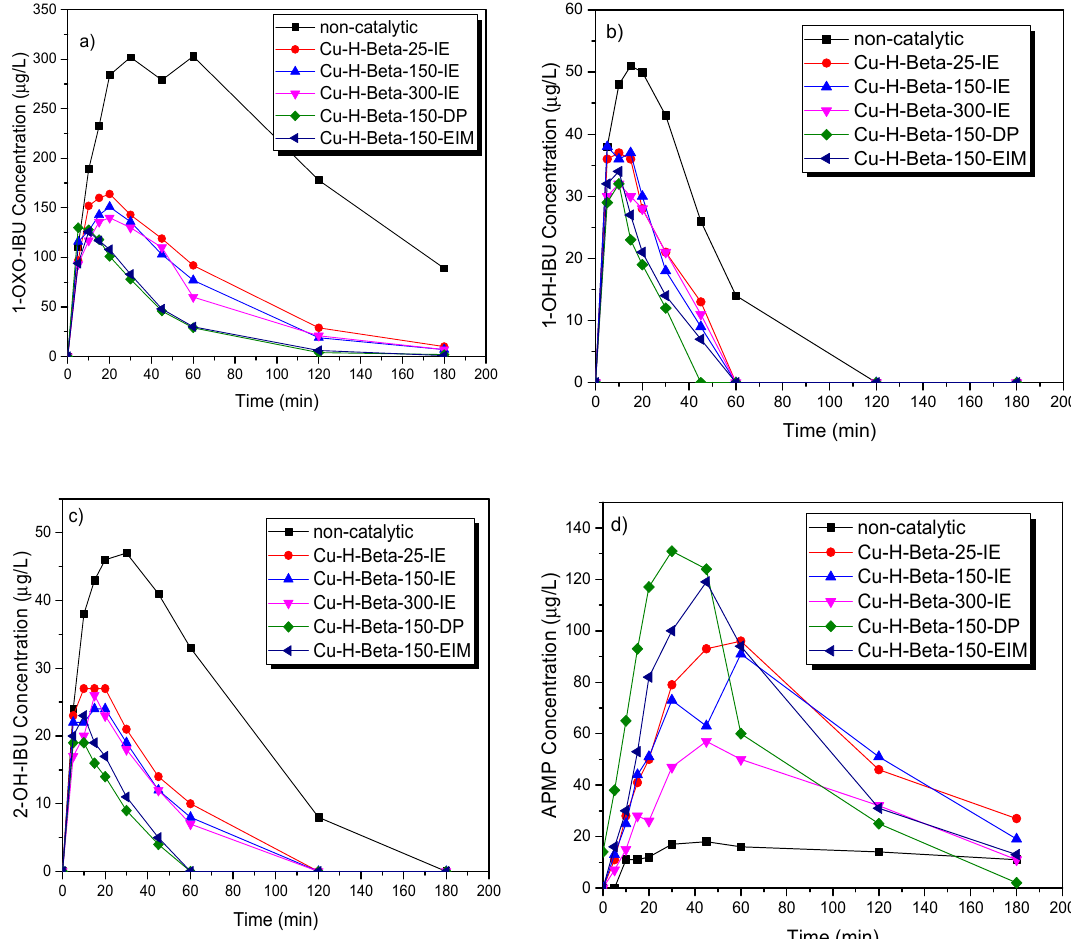
Figure 7. ( a ) 1-OXO-IBU, ( b ) 1-OH-IBU, ( c ) 2-OH-IBU, and ( d ) APMP concentration during the decomposition of IBU in the presence of 2.5 mL/min nitrogen. [IBU] = 10 mg/L, gas flow rate = 450 mL/min, T = 20 °C, stirring rate = 1070 rpm.